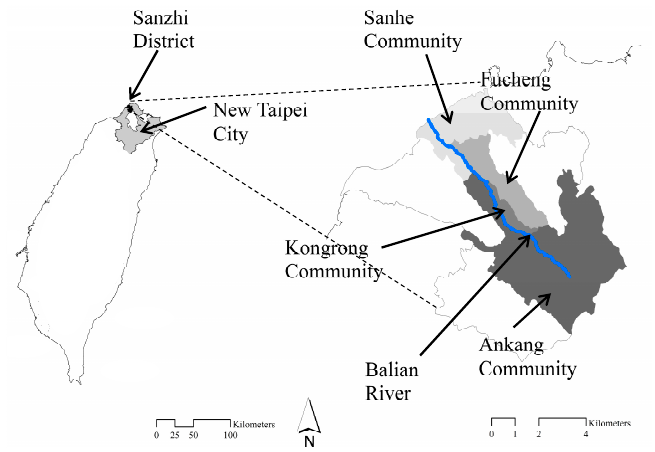
Figure 1. Location of the study area.